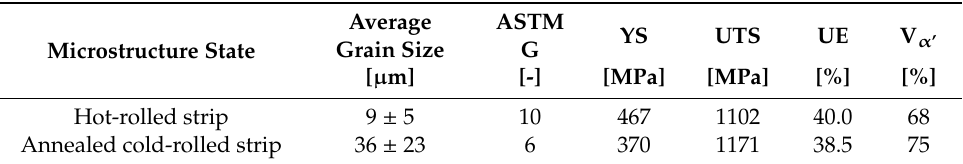
Table 2. Average grain size of austenite, mechanical properties, and deformation-induced α´martensite fraction (V α´ ) after tensile stress.